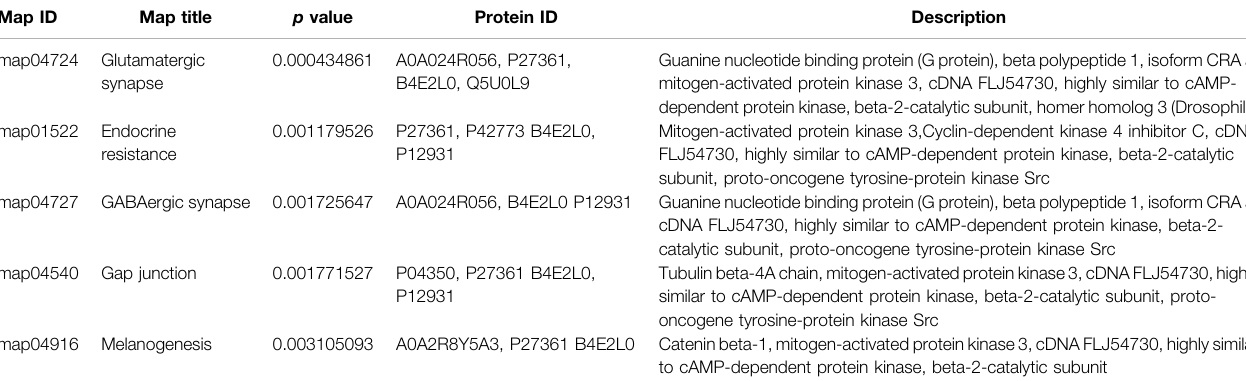
TABLE 2 | Representative fi ve enriched KEGG pathway terms of DEP.